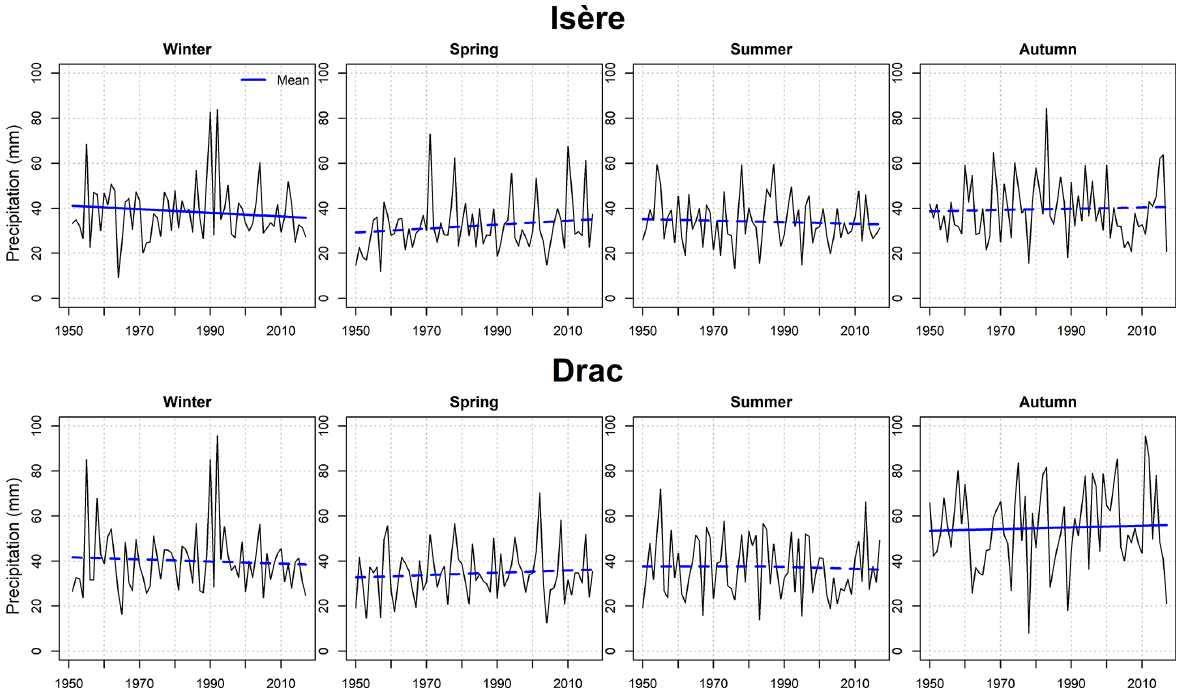
Figure 11. Seasonal maxima of daily precipitation for the Isère River catchment (top) and the Drac River catchment (bottom) over the period 1950–2017. The blue lines represent the evolution of the mean seasonal maximum obtained with the best non-stationary GEV model, following the methodology of Blanchet et al. (2021a). Non-significant trends are represented by dotted lines. The trend is considered as significant if the non-stationary model is significantly better than the stationary model according to the likelihood ratio test ( p value < 5%).